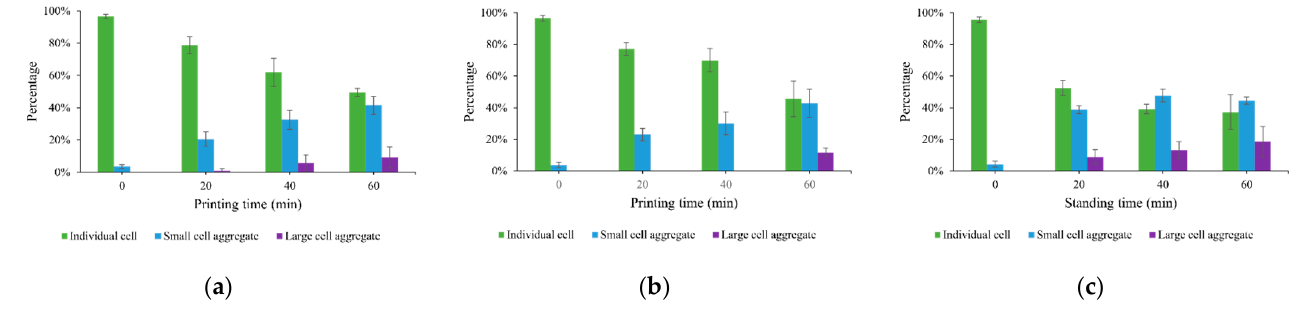
Figure 5. Cell existing forms at the bottom of the bioink reservoir using the bioink composed of 0.5% ( w / v ) sodium alginate and a cell concentration of ( a ) 1 × 10 6 cells/mL, ( b ) 1.5 × 10 6 cells/mL, and ( c ) 2 × 10 6 cells/mL.